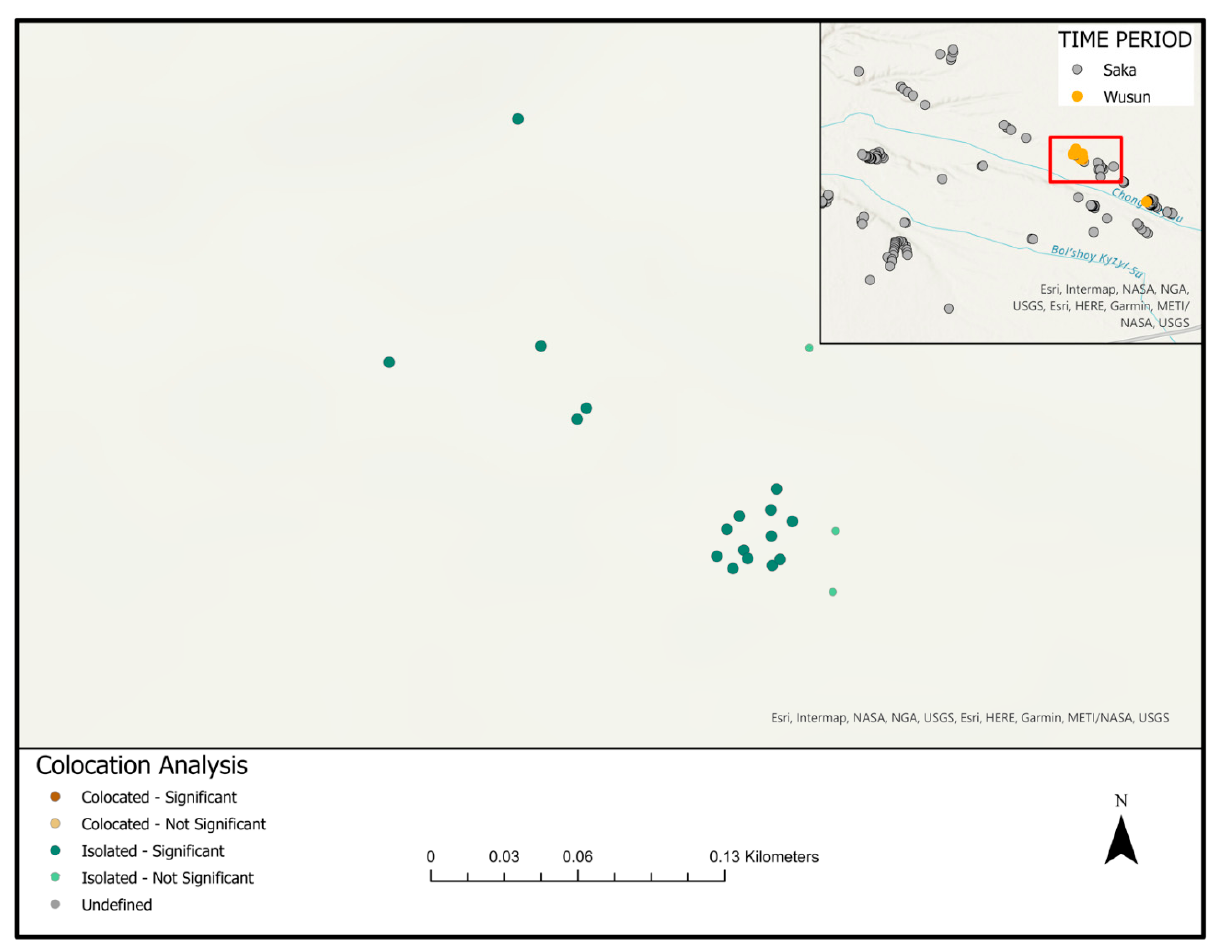
Figure 10. The results of the co-location analysis are indicated in the key and correspond to the main map (area in the red box in the inset map). In this particular cluster, all but two Wusun Kurgans are statistically spatially isolated from the Saka Kurgans. The two lighter green locations are still considered isolated, yet do not make statistical significance